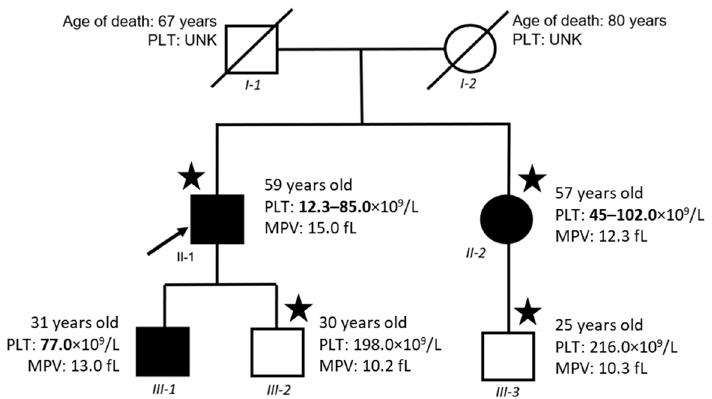
Figure 1. Proband’s (II1) family pedigree shows segregation of macrothrombocytopenia, platelet count (PLT), and mean platelet volume (MPV). Squares represent male, circles represent female individuals, black squares and circles mean macrothrombocytopenia. The samples with an asterisk were analyzed by whole-exome sequencing. UNK—unknown.